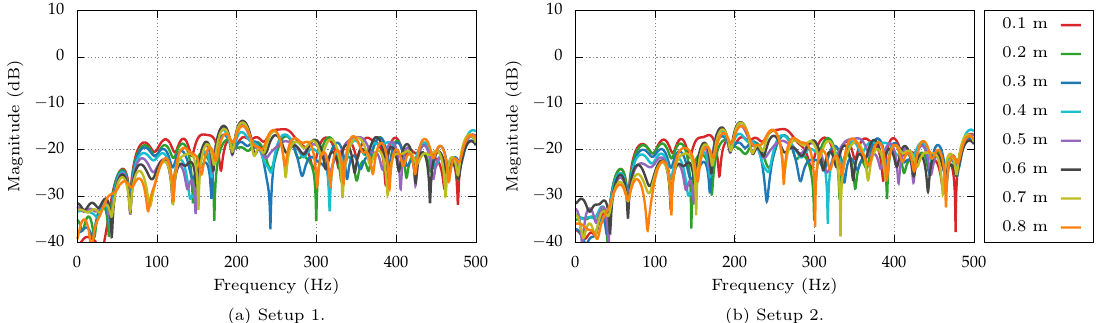
Figure 10. The amplitude functions of the frequency functions of the impulse response estimates for the secondary paths between top casing panel’s selected actuator and the error microphone adjacent to the top casing panel, at all distances, in both setups.